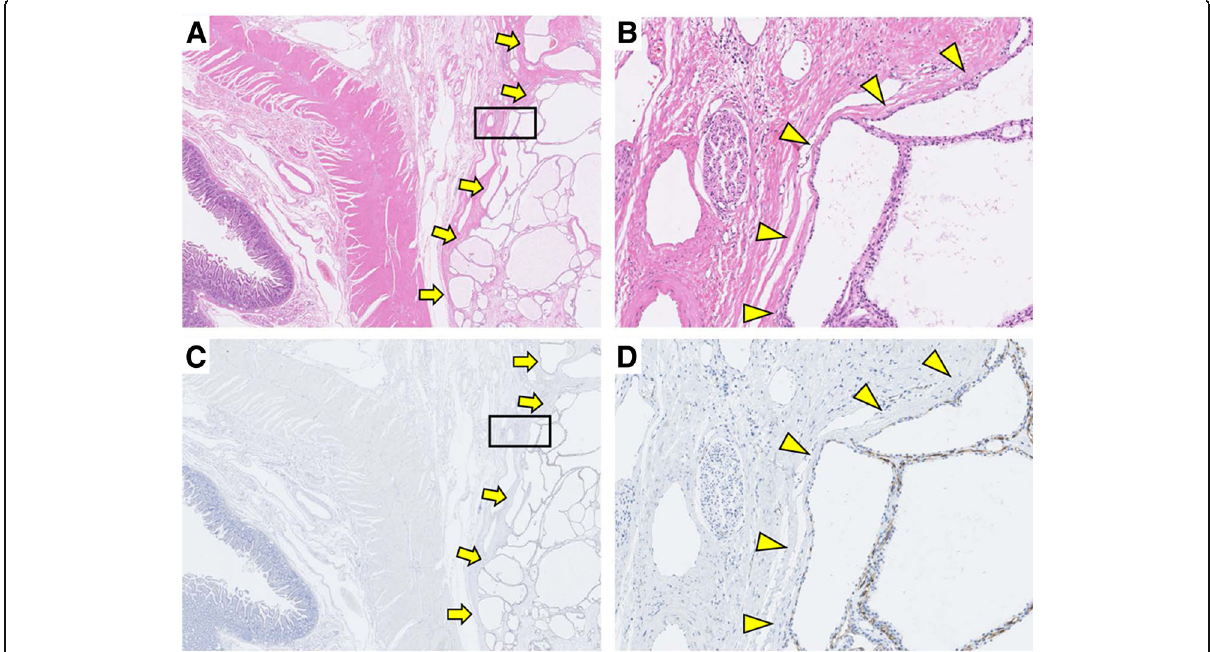
Fig. 6 a The border between the pancreas and SCN (arrows) (HE). b Close-up of the square area of ( a ). The border between the pancreas and SCN (arrowheads) (HE). c The VEGFR2-stained vascular tissue around SCN (right-side arrows). The pancreas and duodenum were not stained by VEGFR2 (left-side arrows). d Close-up of the square area of ( c ). VEGFR2 specifically stained the vascular region around SCN. The border between the pancreas and SCN